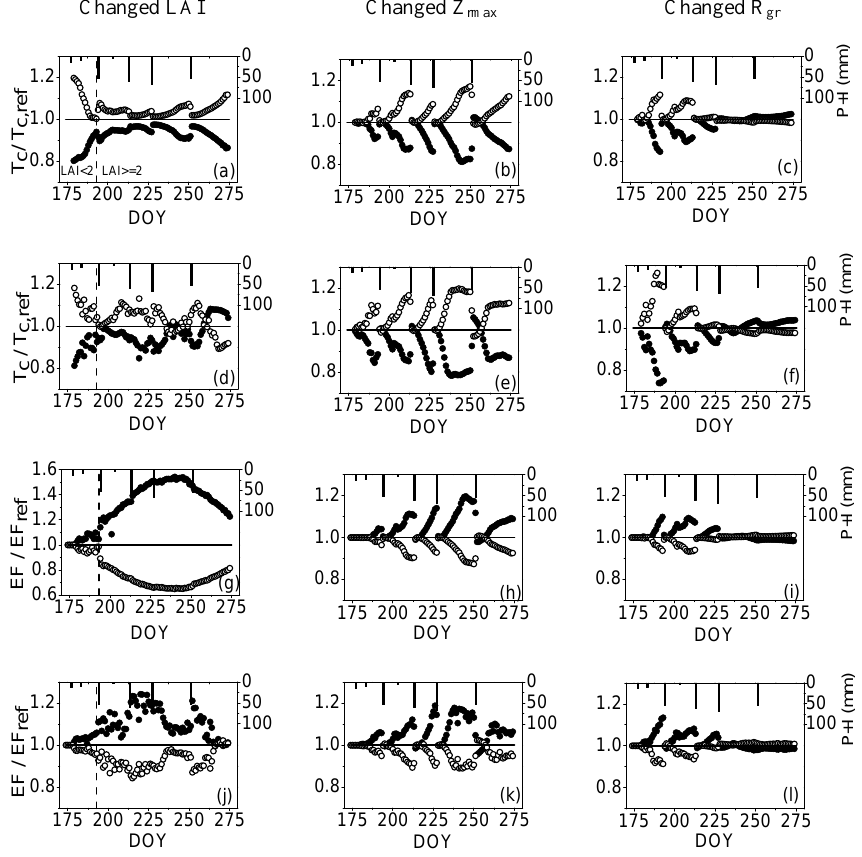
Figure 10. Relative daily variations, under changed leaf area index (LAI), maximum rooting depth ( Z rmax ) , and root growth rate ( R gr ) , in crop transpiration: (a) – (c) , using the ET ind method, (d) – (f) , using the ET dir method; and in the evaporation fraction: (g) - (i) , using the ET ind method; (j) - (l) , using the ET dir method, with measured precipitation and irrigation; ◦ depicting increased LAI, Z rmax , and R gr by 20%, • depicting decreased LAI, Z rmax , and R gr by 20%. Note that the scale for (g) differs from for other